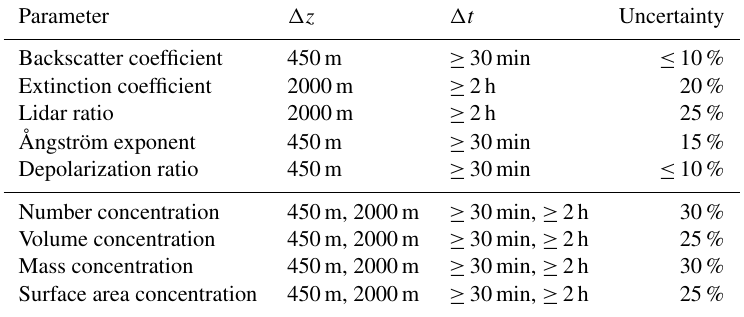
Table 1. Overview of main lidar products (smoke optical and microphysical properties) and typical vertical window lengths, (cid:49)z (effective vertical resolution) used in signal profile smoothing (backscatter and depolarization ratio), regression analysis (extinction), and typical time periods, (cid:49)t , of signal averaging (effective temporal resolution). Typical uncertainties in the optical properties at 355 and 532nm and the derived microphysical properties are given in the right column. Uncertainties in the 1064nm backscatter coefficient and respective Ångström exponents (using 1064nm backscatter) are around 20% and 25%, respectively. Microphysical properties can be obtained by means of the conversion method (from backscatter profiles; (cid:49)z = 450m) or by applying the inversion-with-regularization technique to the set of three backscatter and two extinction profiles ( (cid:49)z = 2000m). Parameter (cid:49)z